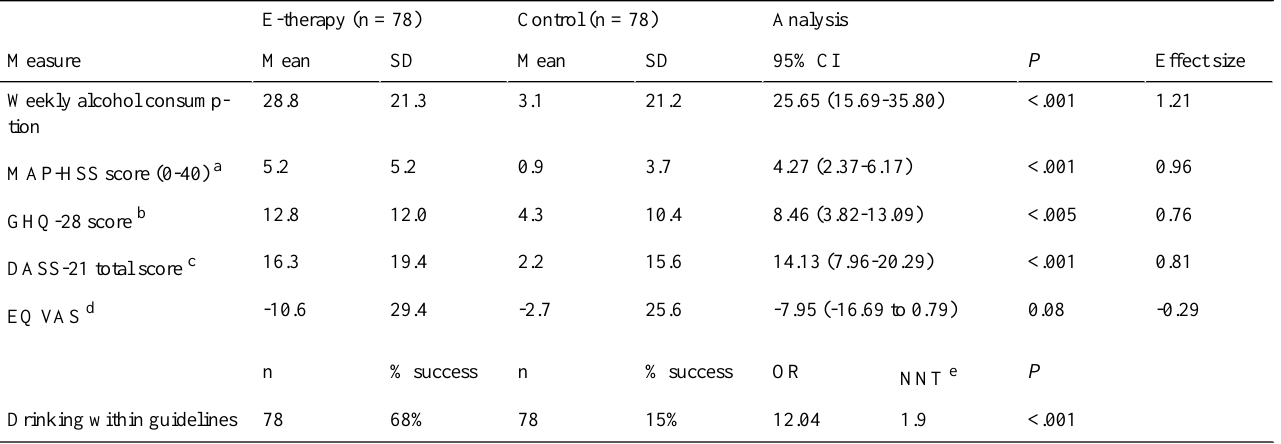
Table 2. Difference scores by treatment condition at 3 months